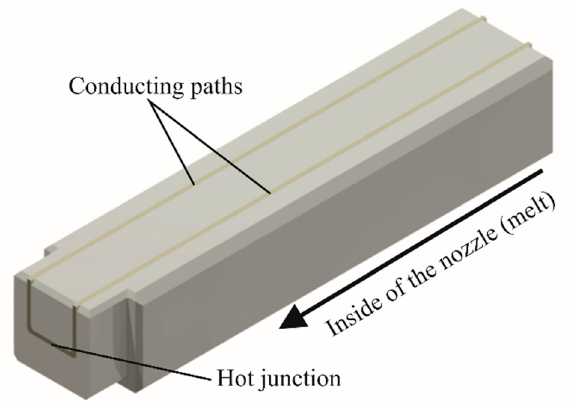
Figure 11. Ceramic insert showing the conducting paths of the Ni/Ni-20Cr thin film thermocouple.